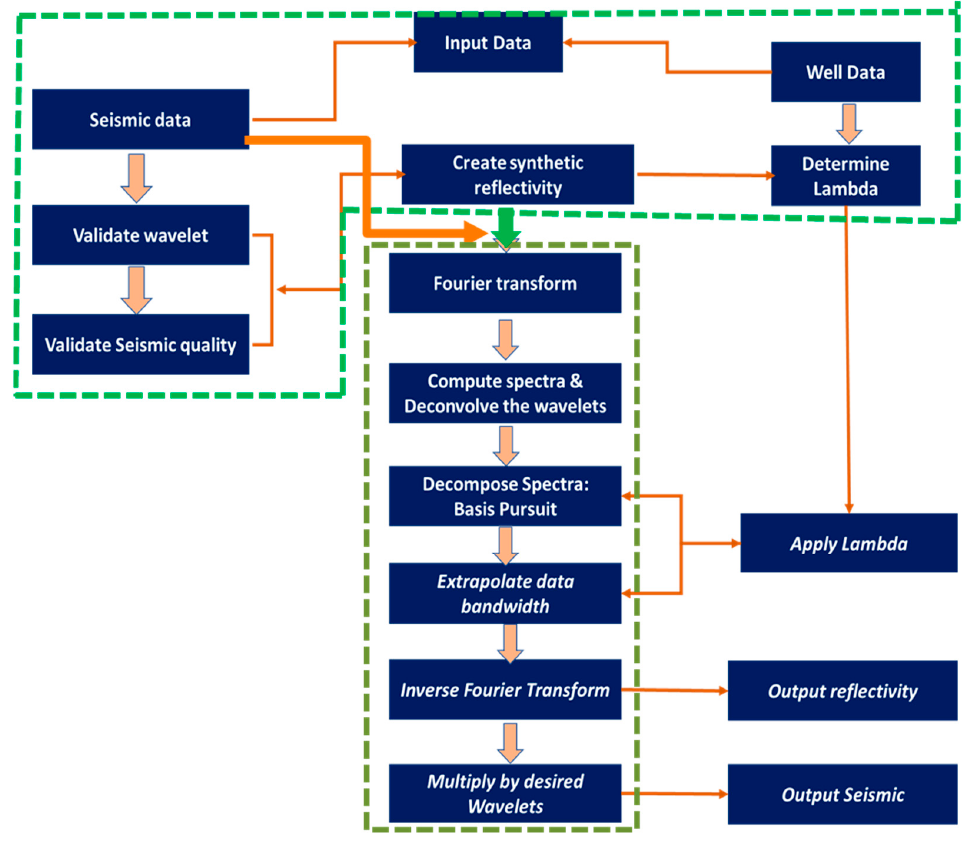
Figure 10. Algorithmic scheme of the applied techniques.